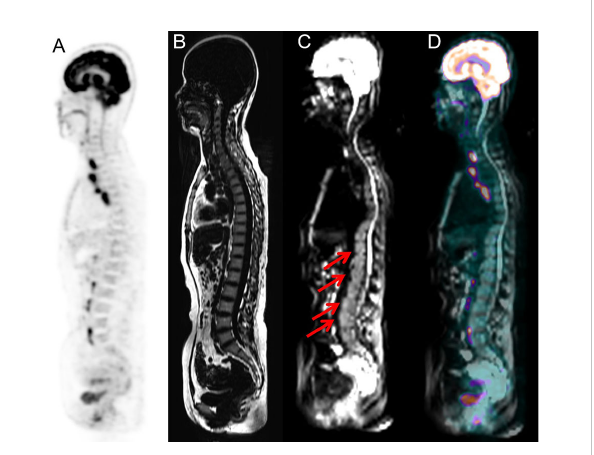
FIGURE 3 Images of a 51-year-old woman with small lymphocytic lymphoma. BMI was detected via PET/MRI due to the presence of intense signal on the MRI (arrows), while PET did not show heterogeneously high FDG uptake. The presence of BMI was con fi rmed by routine staging BMB, which was performed at the level of the posterior iliac crest. (A) PET image derived from PET/MRI. (B) TIWI image derived from integrated PET/MRI. (C) DWI image derived from integrated PET/ MRI. (D) Fused whole-body integrated PET/MRI.